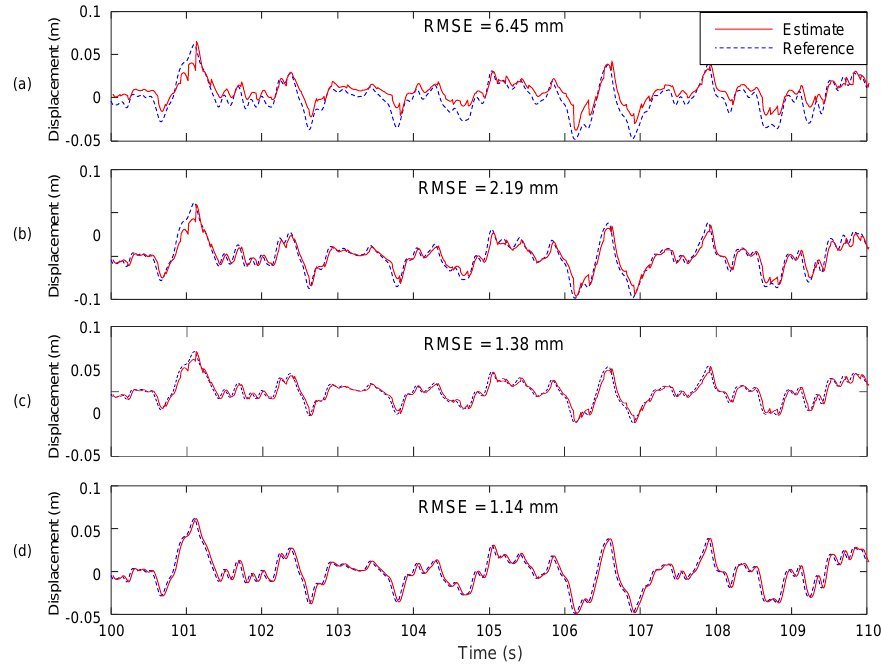
Figure 11. Comparison of RMSE of the proposed system with other Kalman filter based displacement estimation techniques (for a random vibration in Case 2): ( a ) Smyth and Wu [24]; ( b ) Kim et al. [25]; ( c ) Kim et al. [27] and; ( d ) the proposed method.